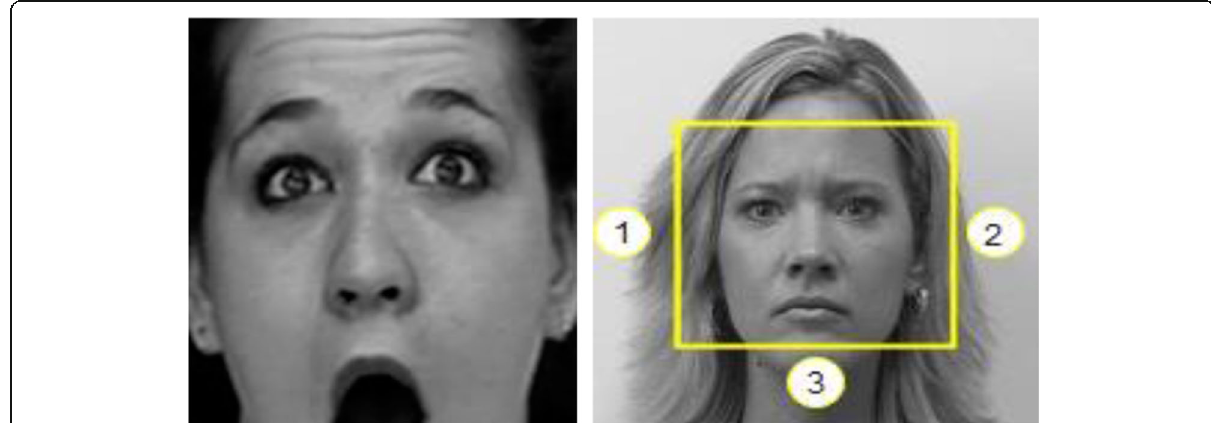
Fig. 6 Viola – Jones face detection with mouth missing (left): Border 3 must cover the whole mouth only, whereas Borders 1 and 2 must cover the face region (right)